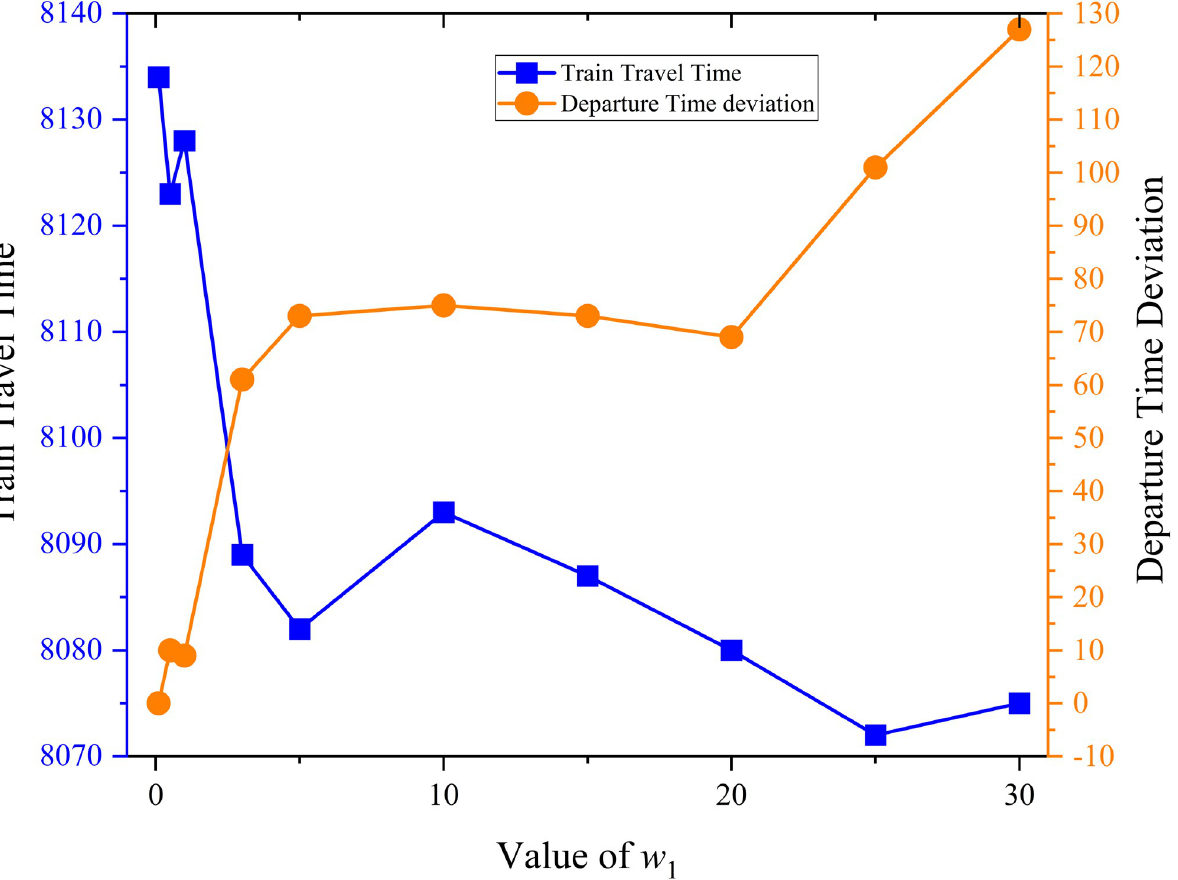
Fig 10. Contrast between train travel time and departure time